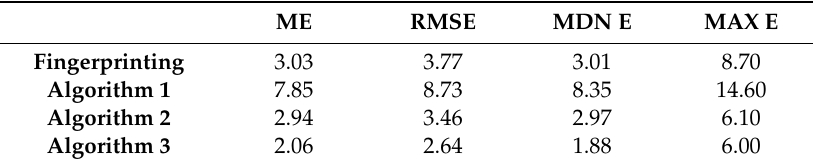
Table 1. Summary of test results for static localization algorithms.